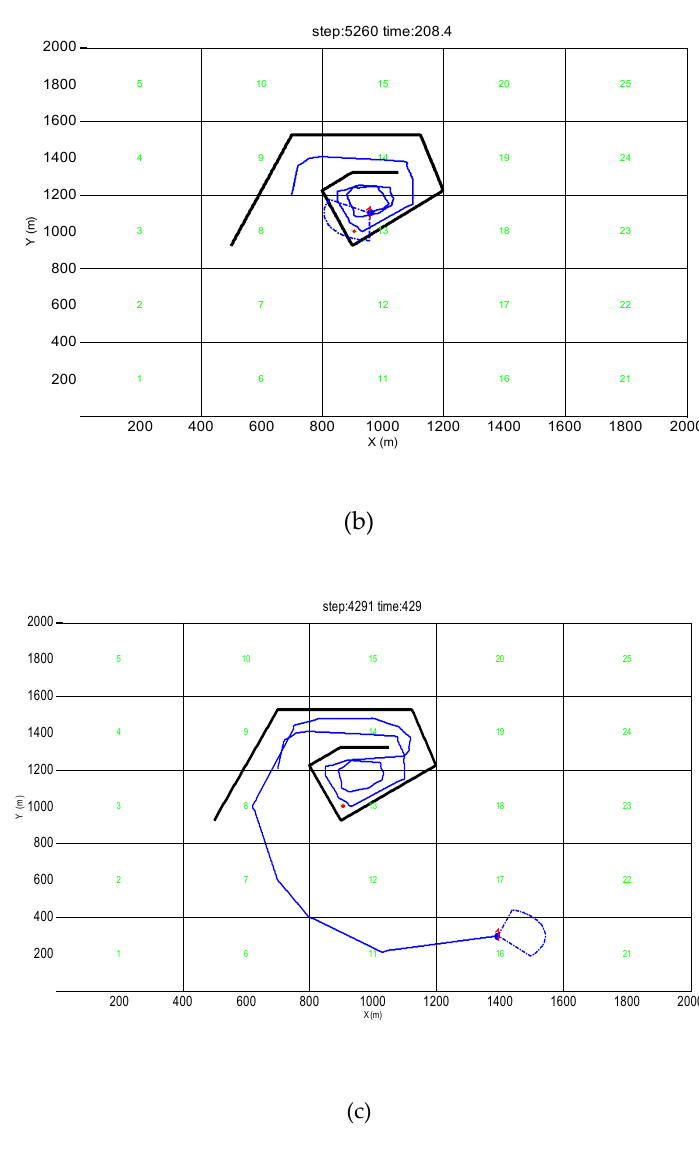
Figure 14. Trap obstacles environment obstacle avoidance trajectory. ( a ) PGOA (Predictive guidance obstacle avoidance). ( b ) APF (Artificial potential field). ( c ) PSO (Particle swarm optimization).